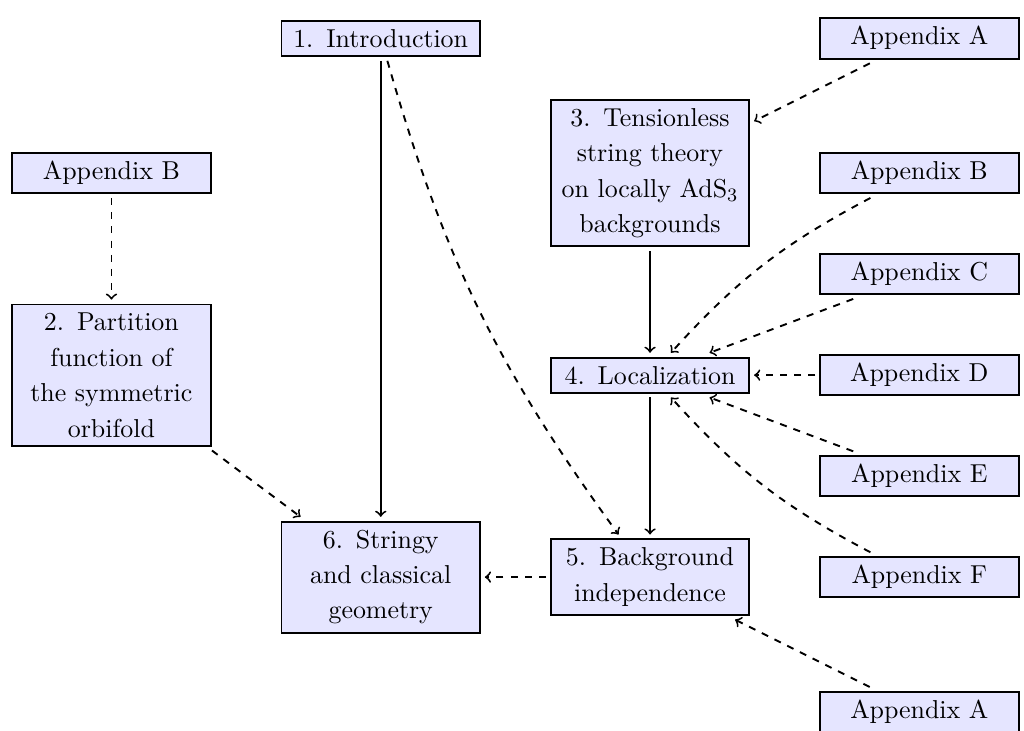
Figure 4 . The basic organization of the paper. Arrows indicate strong logical dependencies and we recommend to read the relevant sections first. Dashed lines indicate weaker